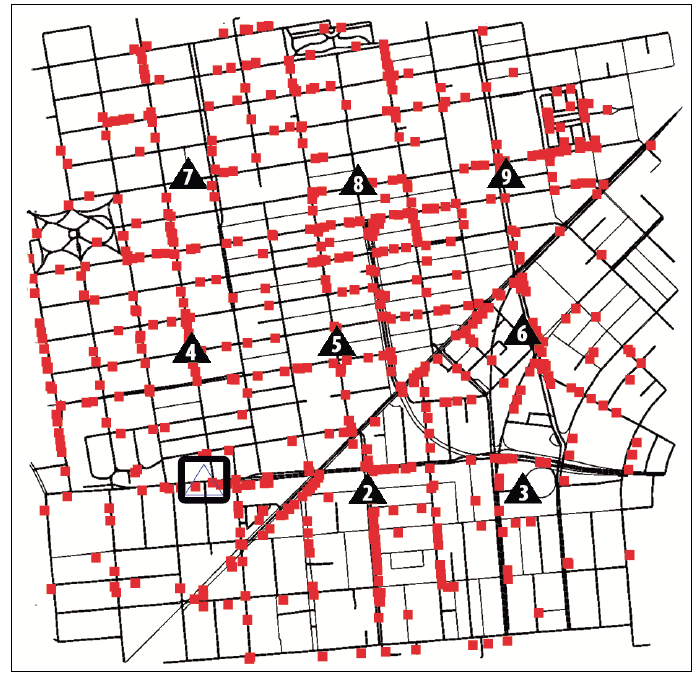
Figure 4. RSUs and vehicle locations in San Francisco when the simulation finished. In this example, RSU 1 is